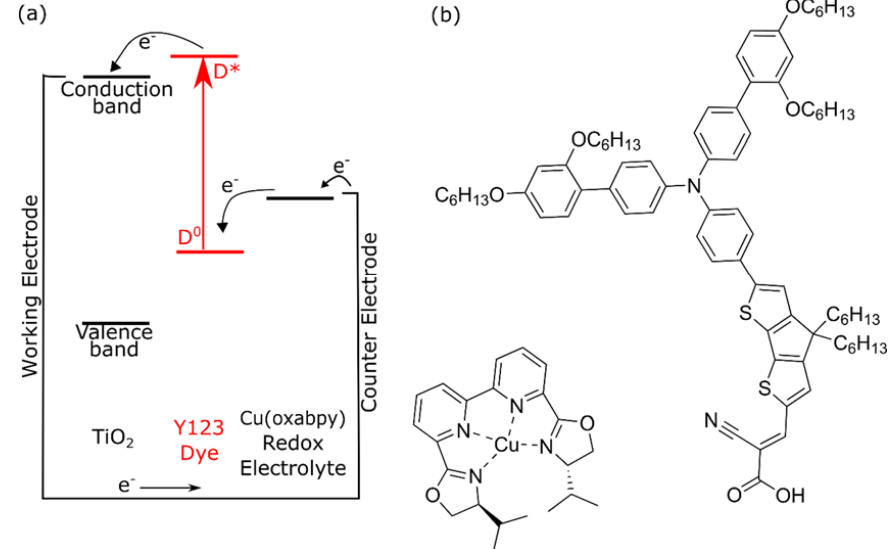
Figure 1. ( a ) Schematic diagram of charge transport processes in a Dye ‐ sensitized Solar Cell (DSC). ( b ) Chemical structures of the Cu(oxabpy) complex ( left ) and the Y123 dye ( right ). One or two bis(trifluoromethane)sulfonimide (TFSI) ions (not shown) serve as counter ‐ ions for the Cu I ‐ and Cu II ‐ based complexes, respectively.